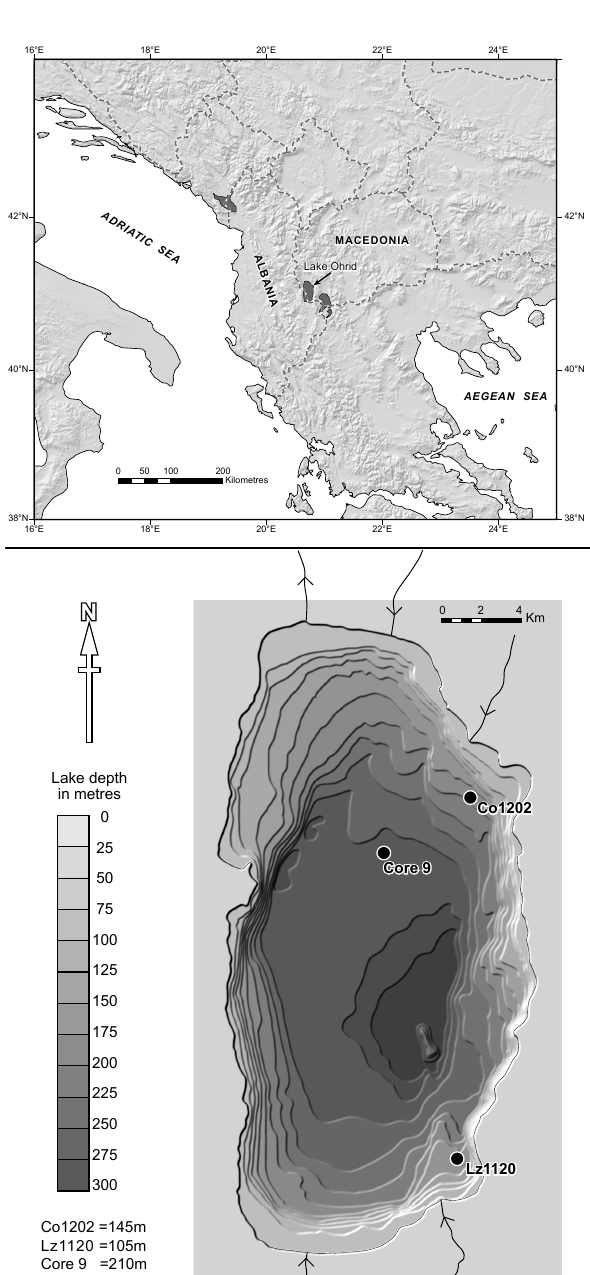
Fig. 1. Map showing the location of Ohrid on the border of Mace- donia/Albania (inset) and the location of coring sites Co1202 (this study), Lz1120 (Wagner et al., 2009) and Co9 (Roelofs and Kilham, 1983), showing the direction of river flow. Modified from Albrecht and Wilke (2008) and Vogel et al.